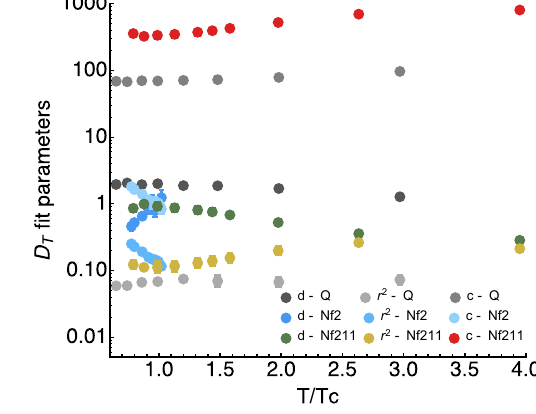
behavior, while the short temperature range spanned by the N f = 2 study at first sight shows opposite behavior. This difference is related to the fact that the former two are carried out in a fixed-scale approach, while the latter are carried out in a fixed box